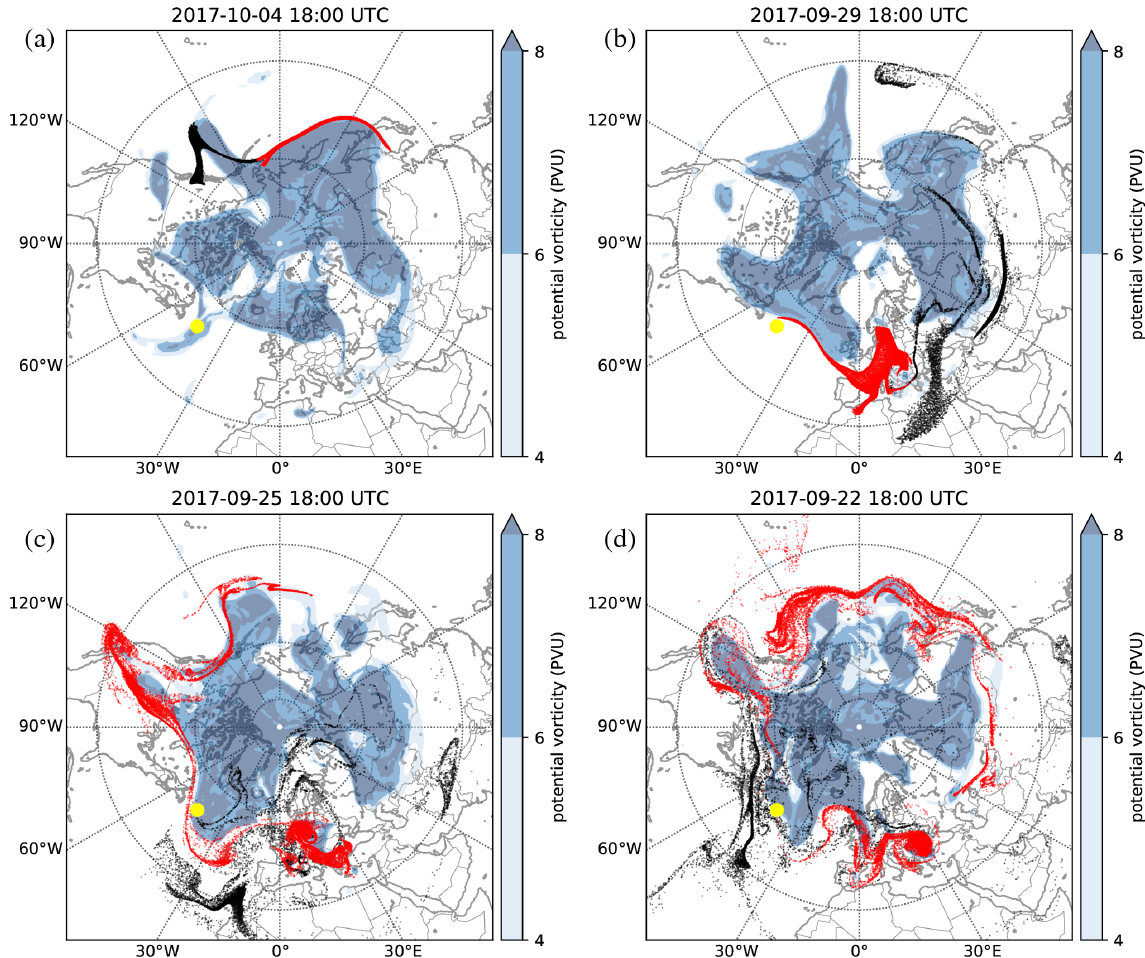
Figure 8. Origins of observed air parcels. Panels show horizontal cuts at 11km altitude. Potential vorticity is shown in shades of blue. The location where air parcels were observed by means of GLORIA 3-D tomography on 7 October is shown in yellow (they form a small disc). The parcel locations at the dates indicated for each panel are shown in black and red. We further distinguish those into red (those that were east of 165 ◦ W on 4 October 18:00UTC) and black (the remaining ones).